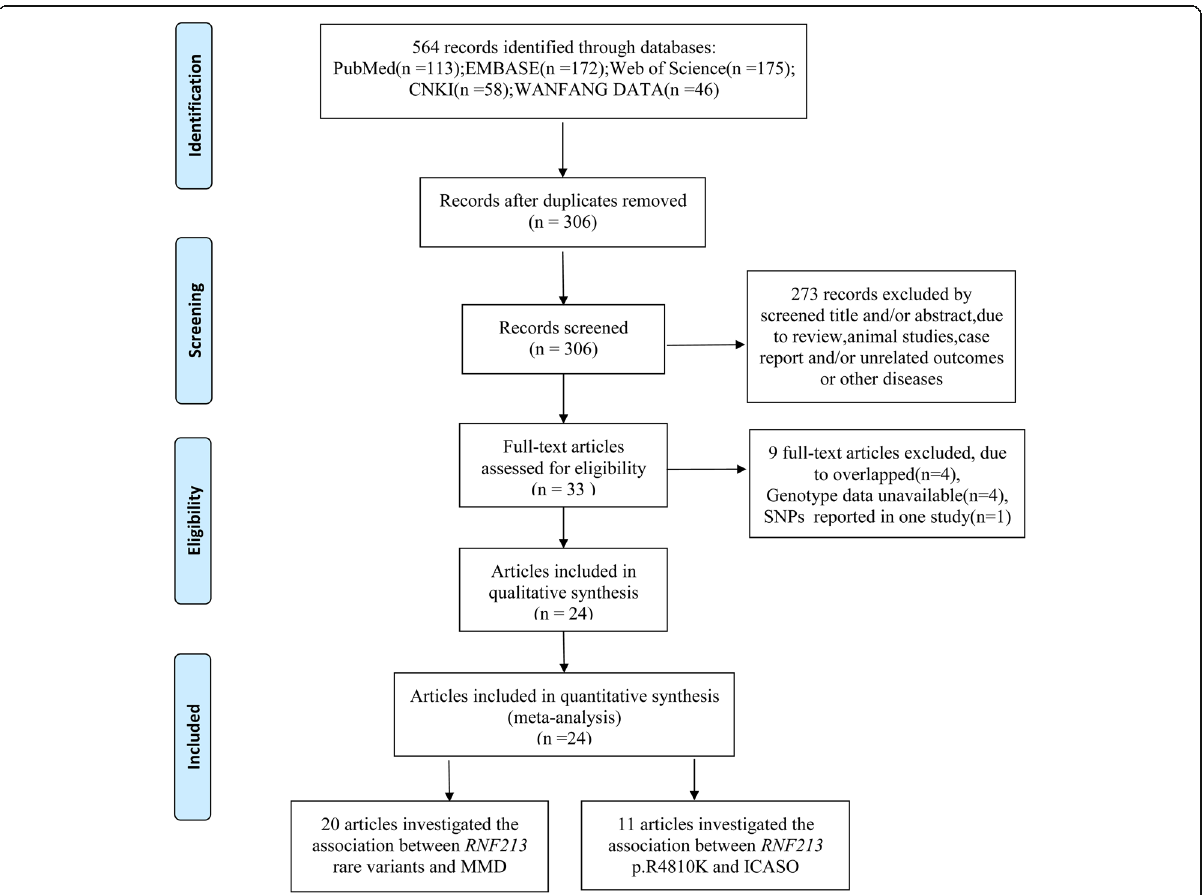
Fig. 1 PRISMA flow diagram of study selection